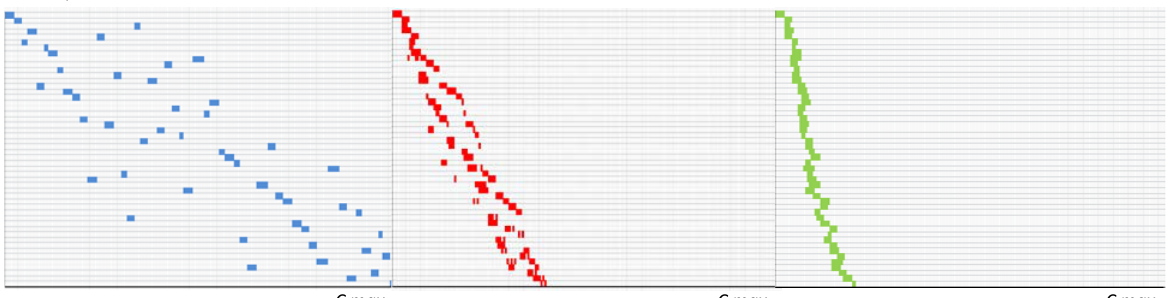
Fig. 13. Results of Serial Programming, BFSM-GA (Active RCPSP) and BFSM-GA (Relaxed RCPSP) for Example 13 with 50 Variables (Left to Right)